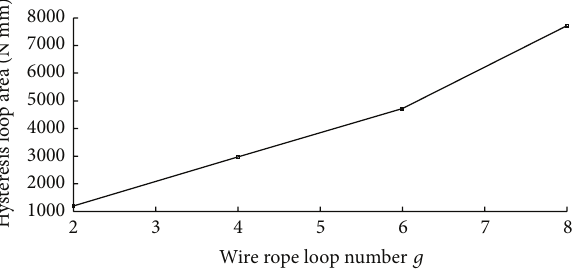
Figure 9: Measured hysteresis loops with different horizontal angle of wire rope loop.